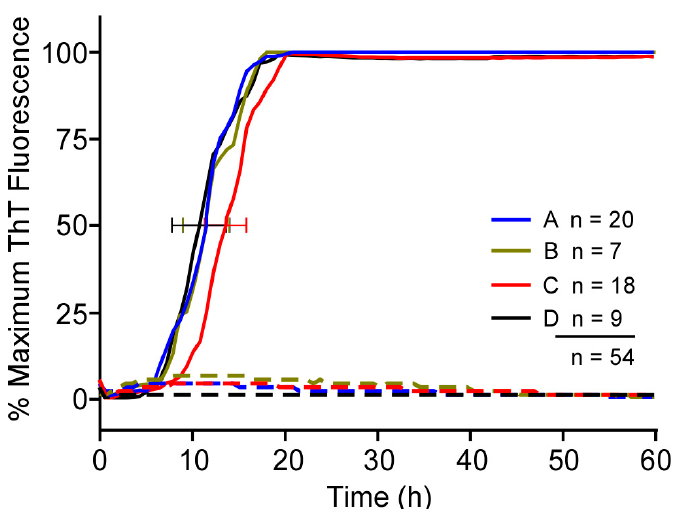
Figure 1. Real-time quaking-induced conversion (RT-QuIC) using four different hamster (Ha) recombinant PrP Sen (rPrP Sen ) substrate batches over approximately one year. Traces represent the average thioflavin-T (ThT) fluorescence from multiple experiments (n) using an individual Ha rPrP Sen 90–231 substrate (Batch A–D). Each quadruplicate RT-QuIC reaction was seeded with 2 μ L of a 5 × 10 − 7 dilution of a single hamster scrapie brain homogenate (263K strain) containing ~100 fg of PrP Res (continuous lines) or a single hamster normal brain homogenate (dotted lines). Error bars denote standard deviation (SD) of time to half maximum ThT fluorescence calculated independently for each Ha 90–231 rPrP Sen batch. All 54 independent experiments were performed as previously described at 42 °C [3]. The increase of the average normalized ThT fluorescence of replicate wells is plotted as a function of time.